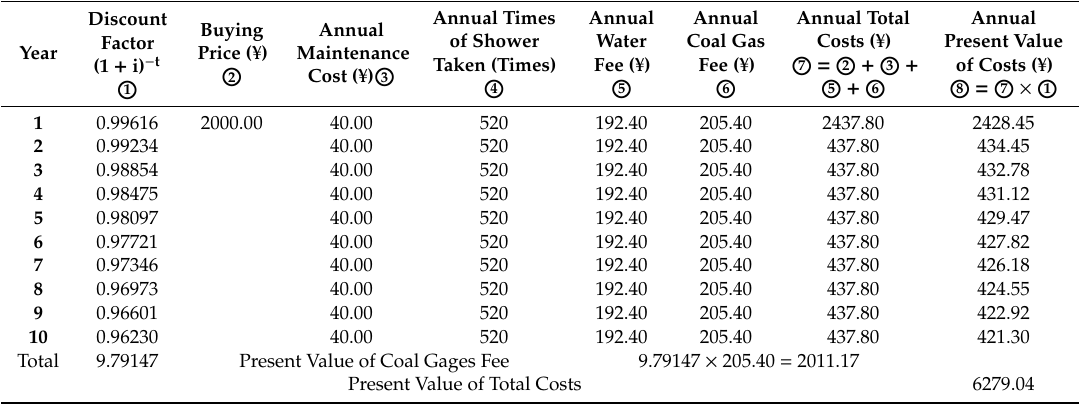
Table 10. Present value of the total costs of using a coal gas water